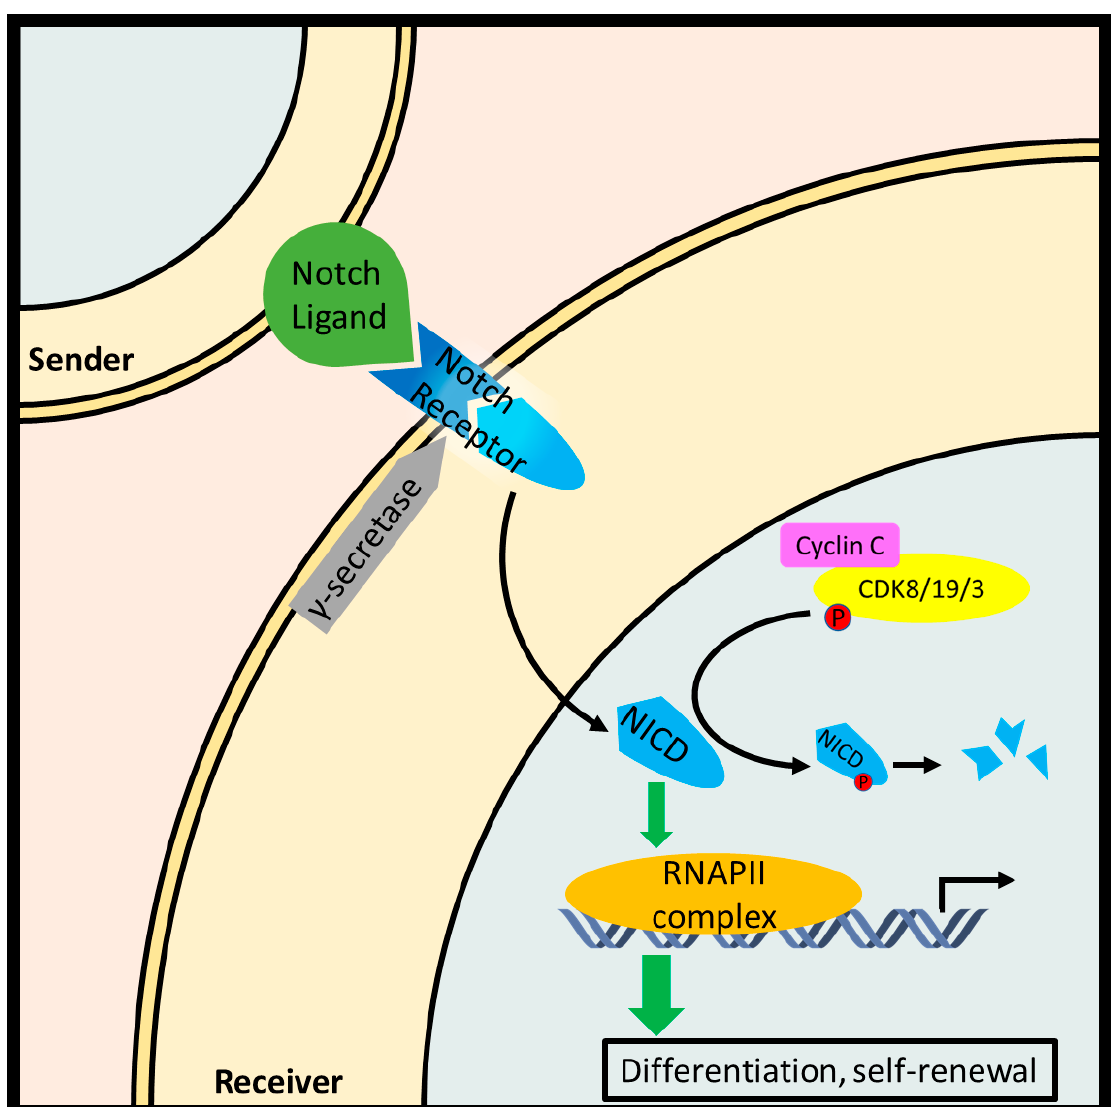
Figure 6. Cyclin C-Cdk8/19/3 inhibit the Notch pathway by phosphorylating the Notch intracellular fragment (NICD) and promoting its degradation in leukemic T cells. In canonical Notch signaling, a contiguous cell exposes a Notch ligand which is recognized by a Notch receptor paralog on a receiving cell. Subsequently, a two-step proteolytic cleavage produces NICD which stimulates with a transcriptionally paused RNA Pol II complex resulting in the downstream expression of genes involved in stem cell differentiation and self-renewal.